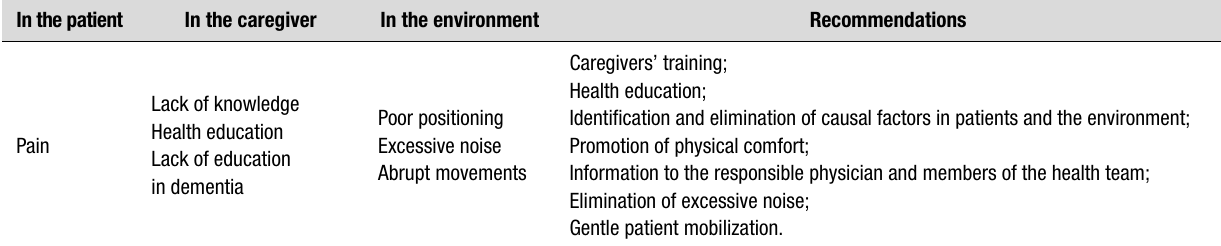
Table 3. Recognition and Management Recommendations for Psychological and Behavioral Symptoms in Severe Dementia. Adapted of Kales (2015) 58 . In the